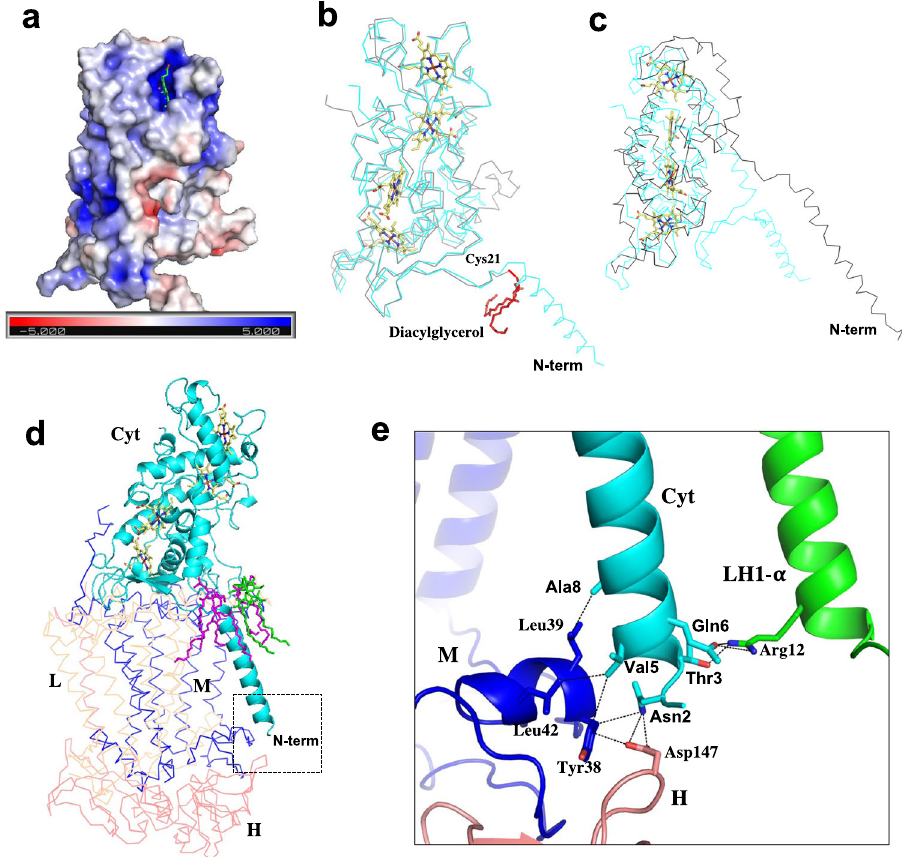
Fig. 2 Structure of the Cyt subunit in the Rpi. globiformis RC. a Surface charge distributions of the Cyt subunit with color codes according to the electrostatic potential from – 5.0 k B T (red, negative charge) to + 5.0 k B T (blue, positive charge) in the scale bars. Heme-1 is shown by green sticks. b Superposition of the C α carbons of the Cyt subunits between Rpi . globiformis (cyan) and Blc. viridis (PDB: 3T6E, gray). The diacylglycerol group attached to the N-terminal Cys21 in Blc. viridis is shown by red sticks. Heme groups in the Rpi . globiformis Cyt subunit is shown by pale yellow sticks. c Superposition of the C α carbons of the Cyt subunits of Rpi . globiformis (cyan) and Rof . castenholzii (PDB: 5YQ7, black). d The Cyt subunit (cyan cartoon) in the Rpi . globiformis RC showing its N-terminal domain surrounded by phosphatidylglycerol (magenta sticks) and detergent (DDM, green sticks) molecules on the periplasmic surface. e Expanded view of the N-terminus of the Cyt subunit marked in d showing interactions with the surrounding M subunit (blue), H-subunit (salmon) and LH1 α -polypeptide (green). Dashed lines indicate several representative distances shorter than 4.0